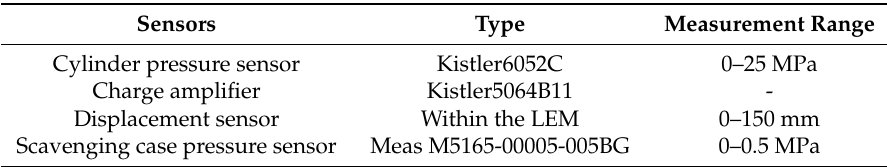
Table 4. Main technical parameters of the sensors.